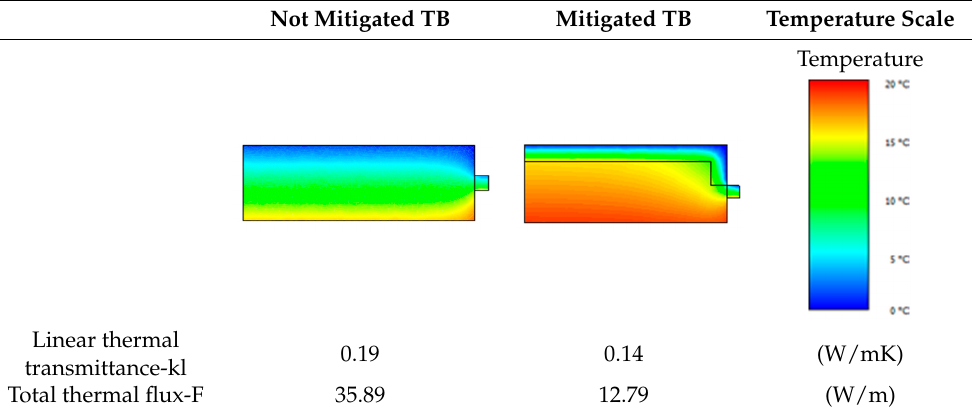
Table 10. W Thermal bridges.